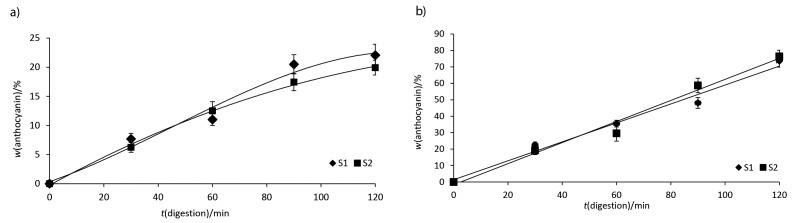
Release of anthocyanins from formulated jelly during digestion in: a) simulated gastric juice and b) simulated duodenal juice. S1=samples with the addition of 5% microencapsulated grape juice, S2=samples with the addition of 10% microencapsulated grape juice